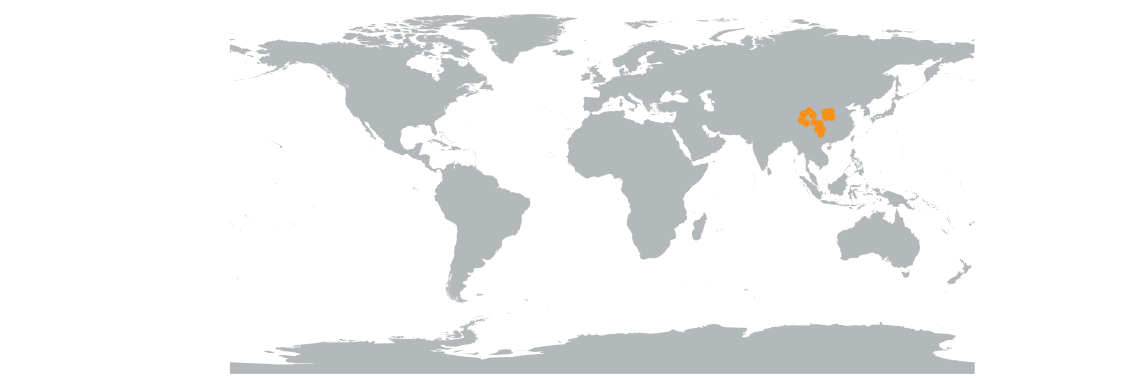
Fig. 31. Distribution of Malus transitoria (Batalin)